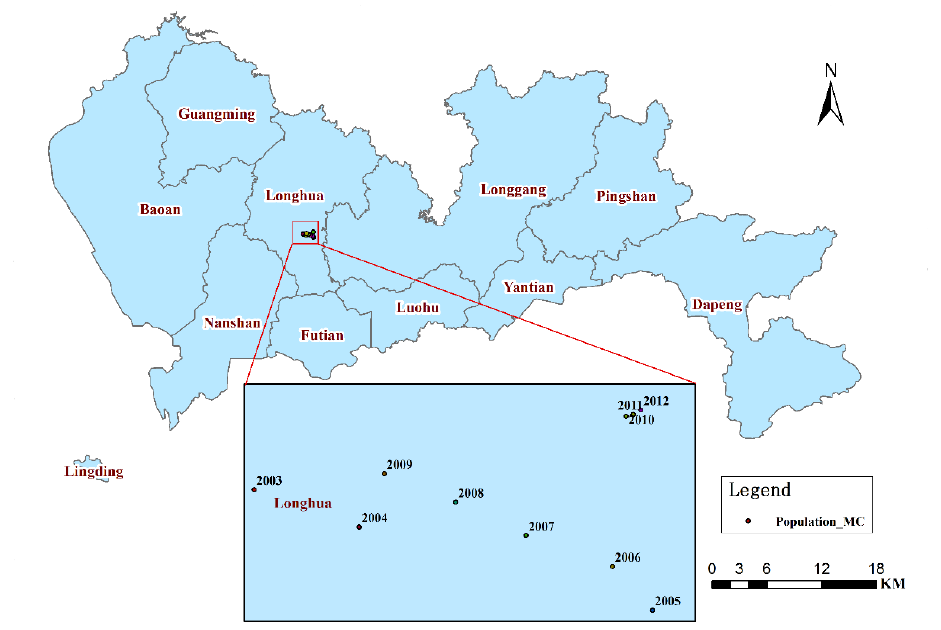
Figure 10. Annual mean center of the total population in Shenzhen from 2003 to